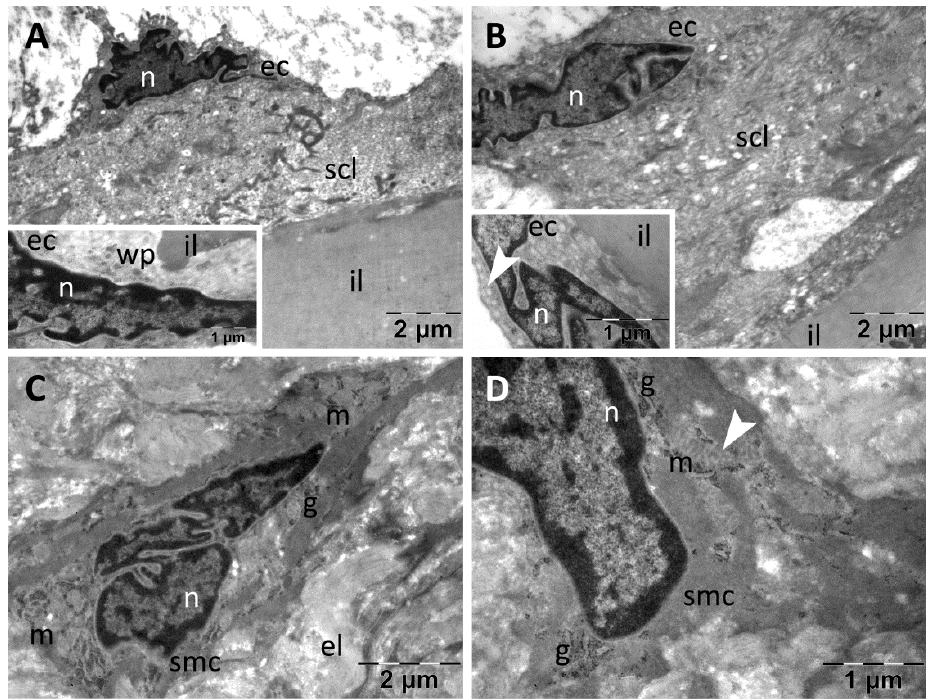
Figure 12. TEM investigation of the descending aorta in rats with HFD for 9 months; the last month with experimental-induced diabetes mellitus and oral administration of Cornus mas L. extract showed almost normal ultrastructure in both intima that contained a heterogeneous subendothelial connective layer ( A , B ), and media ( C , D ) (arrowhead, vesicles of endocytosis in muscle cells and of transcytosis in endothelial cells; ec, endothelial cell; el, elastic lamina; il, inner elastic lamina; g, glycogen; m, mitochondria; n, nucleus; scl, subendothelial connective layer; wp, Weibel–Palade bodies).